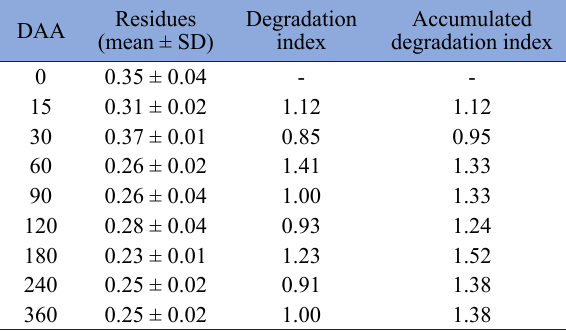
Table 2. Esfenvalerate residues (mg kg −1 ) in